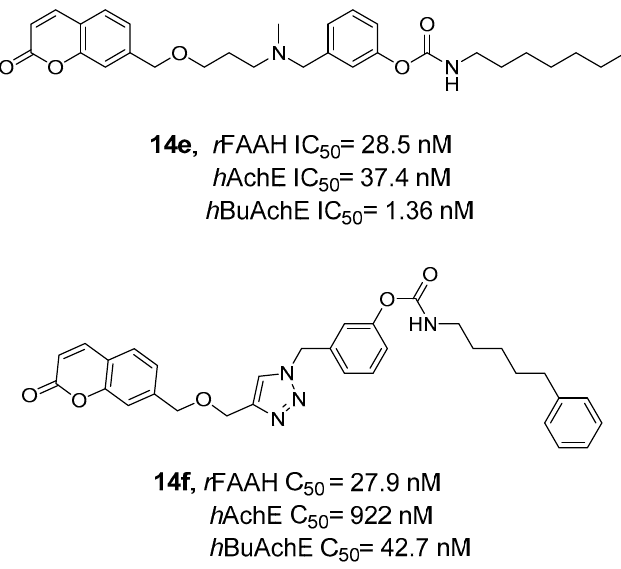
Figure 4. Chemical structure of FAAH/ChE inhibitors 14e and 14f .